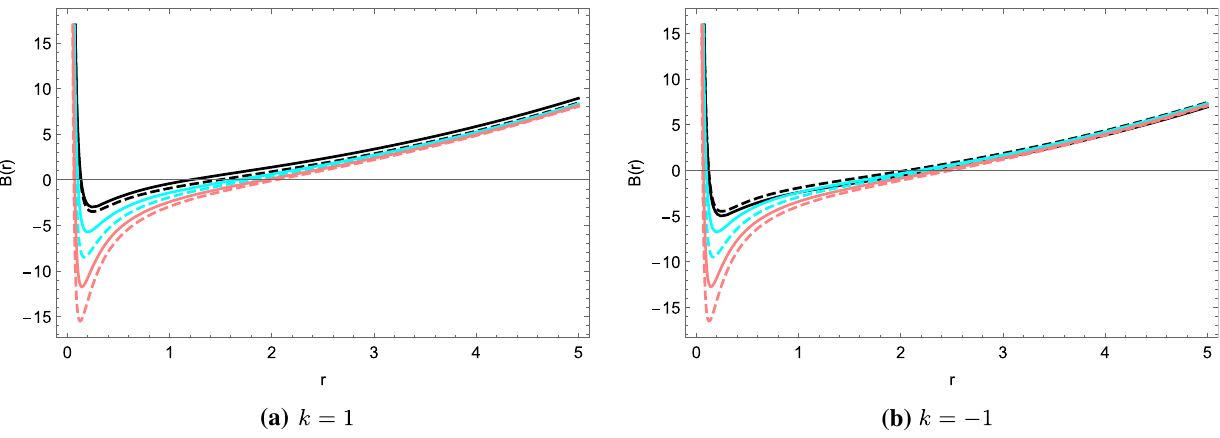
Fig. 2 The black curve represents B RN ( r ) with m 1 = 2. While black dashed curve, cyan curve, cyan dashed curve, pink curve and pink dashed curve correspond to B 0 ( r ) with m 1 = 2 , 2 . 5 , 3 , 3 . 5 , 4 respectively. Other parameters are set as q 1 = 0 . 5 and (cid:3) = − 1